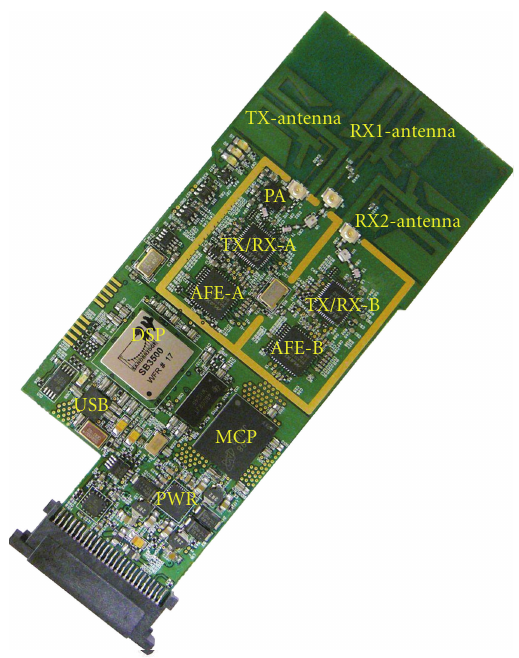
Figure 9: Expresscard top view, overall dimensions 48 × 108